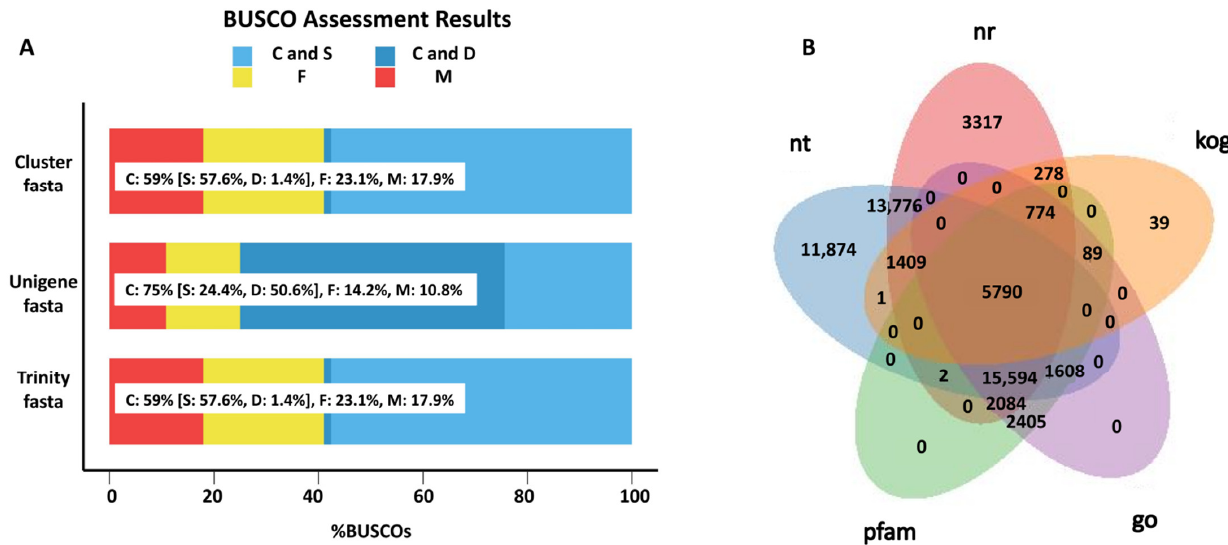
Figure 1. Overview of the transcriptomic analysis. ( A ) BUSCO analysis of the assembled transcripts. Light blue represents complete (C) and single copy (S); deep blue represents complete (C) and duplicated (D); yellow represents fragment (F); red represents missing (M). Trinity.fasta is the sequence assembled by the software Trinity. Cluster.fasta and unigene.fasta were obtained from trinity.fasta by removing the redundant sequence. ( B ) A Venn diagram of the genes annotated in different databases.